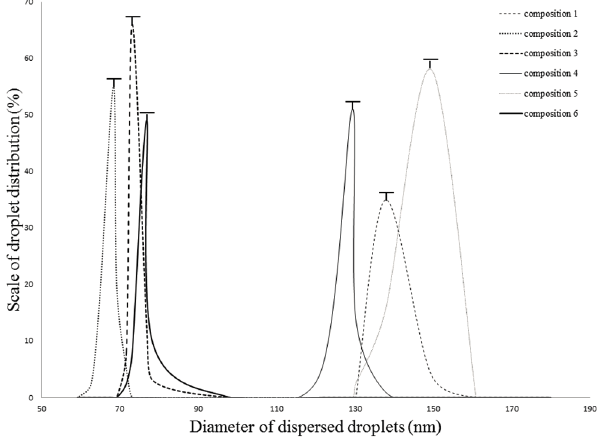
Figure 2. Evaluated droplet size of SMEDDS in water via DLS measurement. Evaluated average droplet sizes: composition 1: 137.81 ± 1.25 nm, composition 2: 68.44 ± 1.05 nm, composition 3: 73.28 ± 0.95 nm, composition 4: 129.31 ± 1.95 nm, composition 5: 149.35 ± 1.00 nm, composition 6: 76.90 ± 1.00 nm. Values are expressed as means ± SD, n =